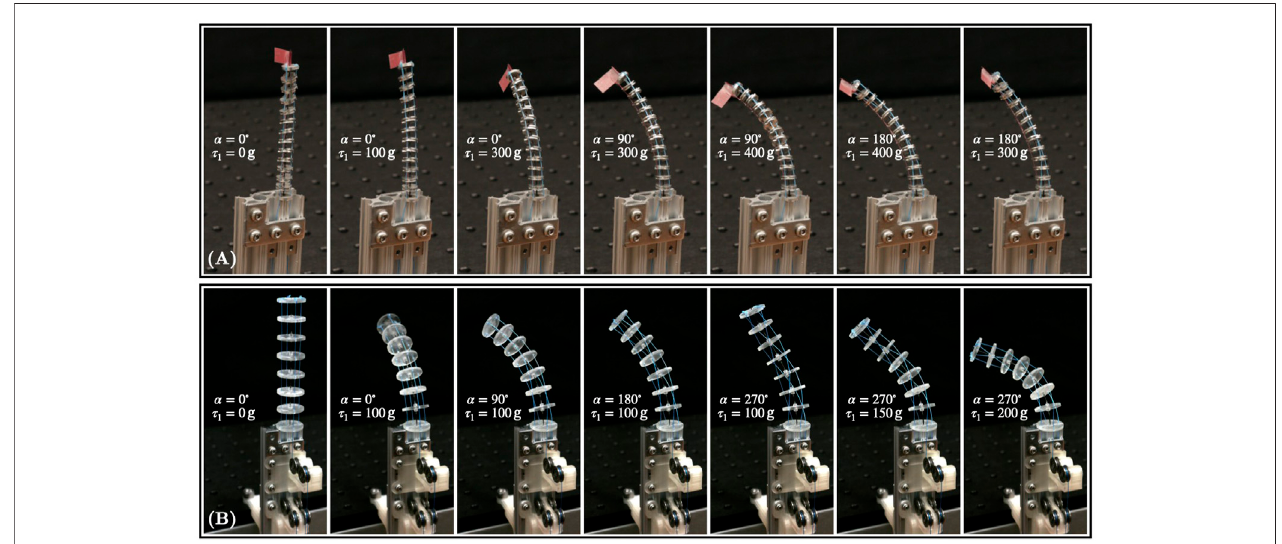
FIGURE 3 | TDCR prototypes. Both prototypes are loaded with different weights on one tendon for different rotation α . (A) First prototype is composed of type-III FSD with fi xed overall length of 60 mm. (B) Second prototype is composed of type-II FSD.